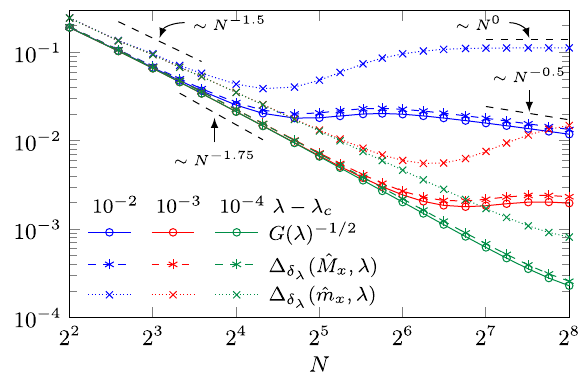
FIG. 4. The crossover between different scaling limits when λ is not tuned exactly to the critical point. Results correspond to the adiabatic limit of the evolution. For given deviation λ − λ we c recover the apparent super-Heisenberg scaling when N is small enough. When the system size is further increased and over to the classical N − 1 = 2 dependence. On the other hand, Δ ð ˆ m ; λ Þ saturates and becomes xindependent on the system δ λ x size in that limit. Nevertheless, notice that even in this case the prefactors in front of N − 1 = 2 ð 0 Þ are enhanced by the vicinity of the ð ˆ M ; λ Þ is closely following the optimal bound critical point. Δ δ x λ set by QFI for all values of the parameters. Dashed lines indicate various scalings and serve as guidance for the eye. Results for the ¼ 0 XXZ model in the external field in Eq. (21) with J z